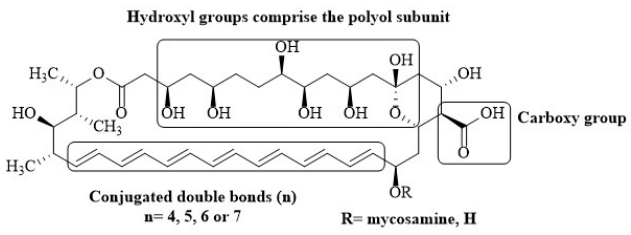
Figure 1. General structure of polyene antibiotics.